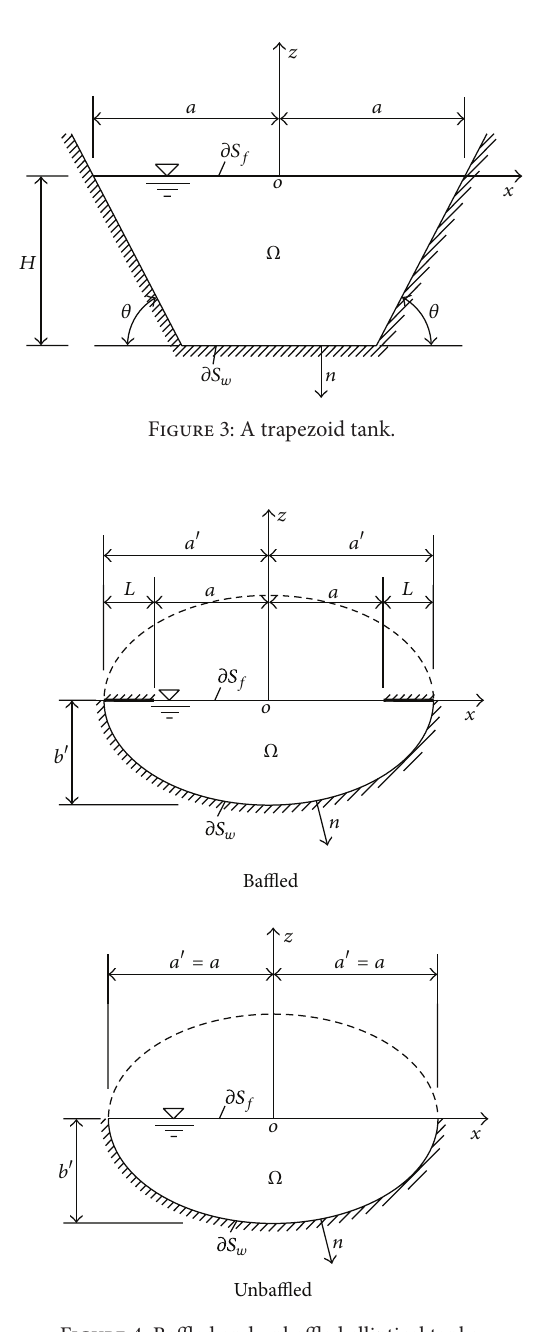
Figure 4: Baffled and unbaffled elliptical